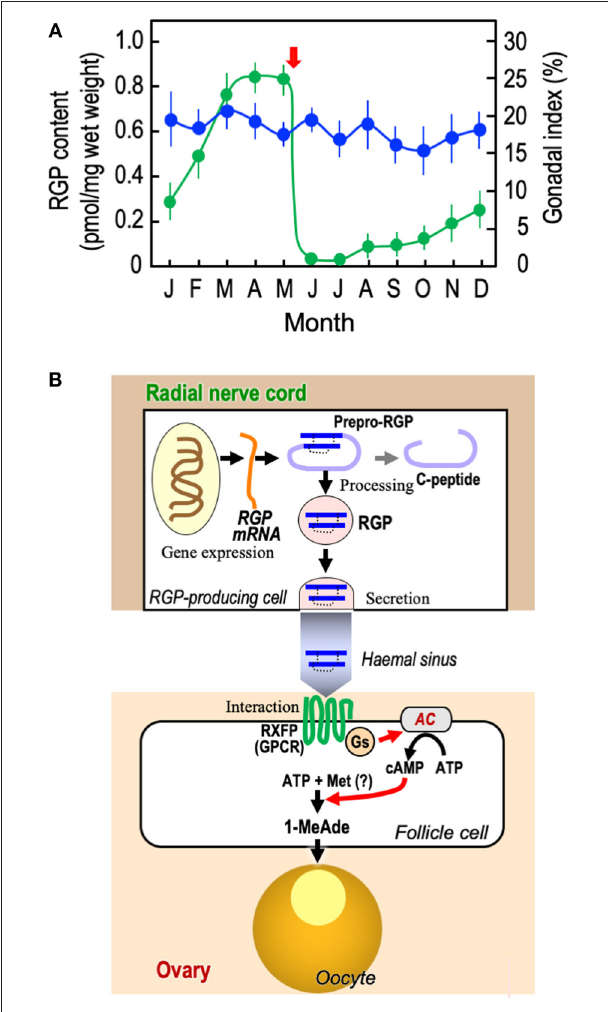
FIGURE 2 | Overview of RGP. (A) Annual changes in RGP content in radial nerve cords and gonadal index in starfish P. pectinifera . Starfish P. pectinifera were collected monthly from Yokosuka (Kanagawa Prefecture, Japan). More than ten individuals (arm length 30–50mm) per group were used for measurement of gonadal index ( ) and the preparation of radial nerve cord extracts for the measurement of RGP content ( ). RGP contents were determined by ELISA (40). The gonadal index was calculated as the gonad weight per body weight × 100. Symbols and bars represent the mean of six independent samples and standard error of the mean (SEM), respectively. Arrow shows timing of spawning. (B) De novo synthesis, secretion, and hormonal action of RGP. AC, adenylyl cyclase; GPCR, G-protein-coupled receptor; Gs, G-protein as adenylyl cyclase stimulator; Met, methionine; and RXFP, relaxin-family peptide